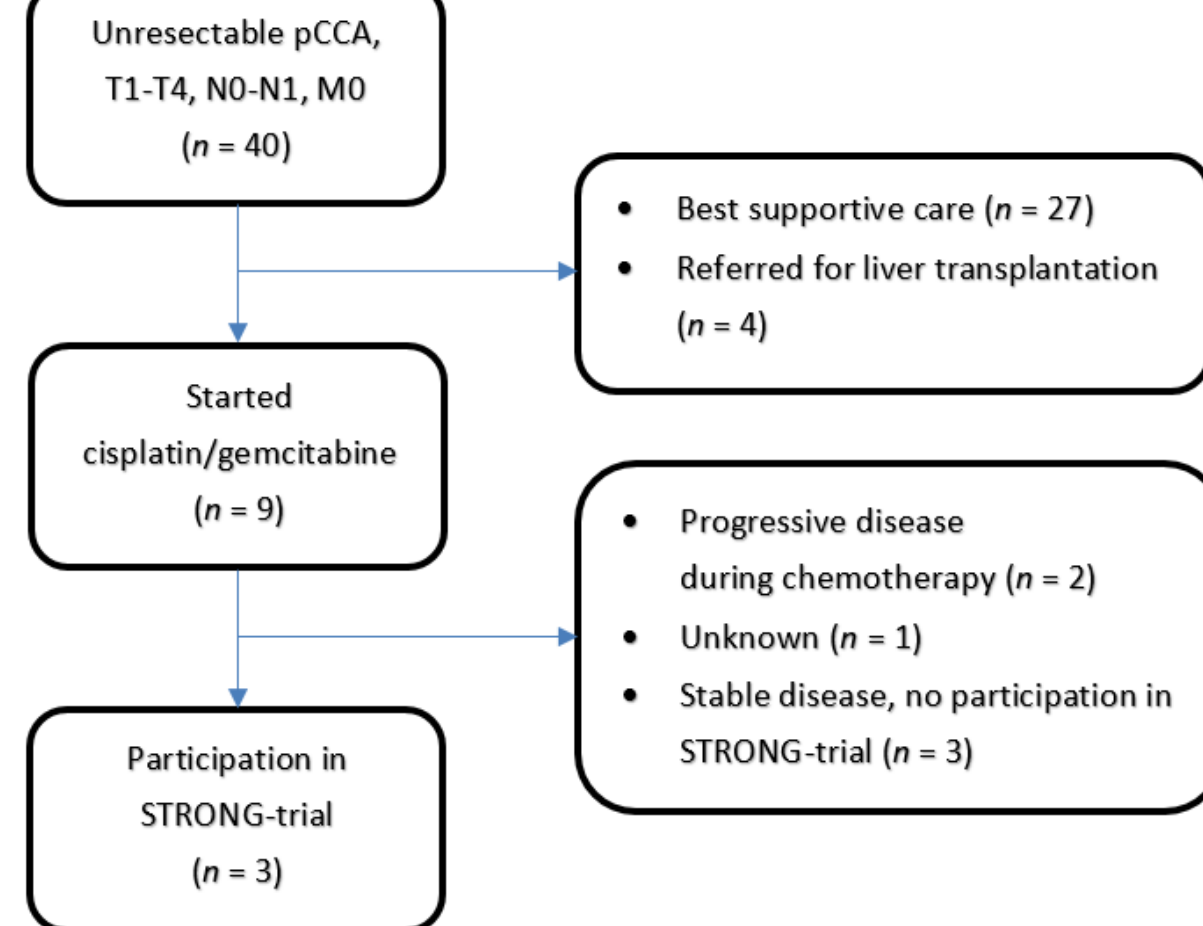
Figure 1. Patients with unresecectable pCCA referred from Erasmus Medical Center during the inclusion period for the STRONG-trial. Of the 6 patients included in the trial, 3 patients were referred from another hospital after chemotherapy and were not included in this overview.